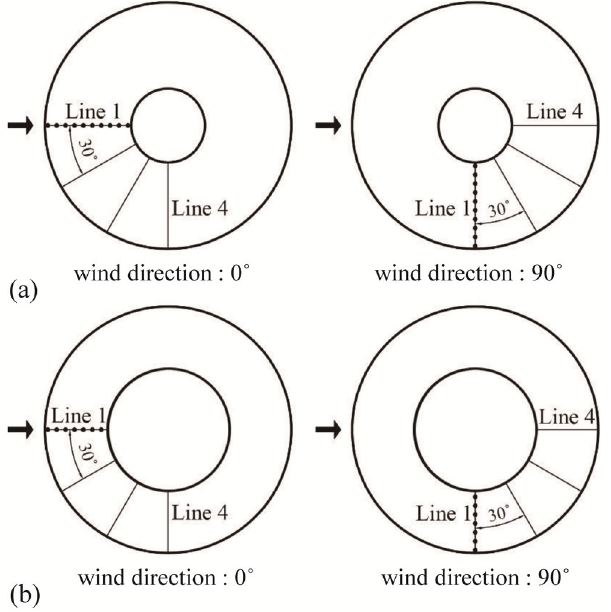
Figure 2 . Pressure taps and wind direction: ( a ) open ratio = 30% and ( b ) open ratio = 50%.